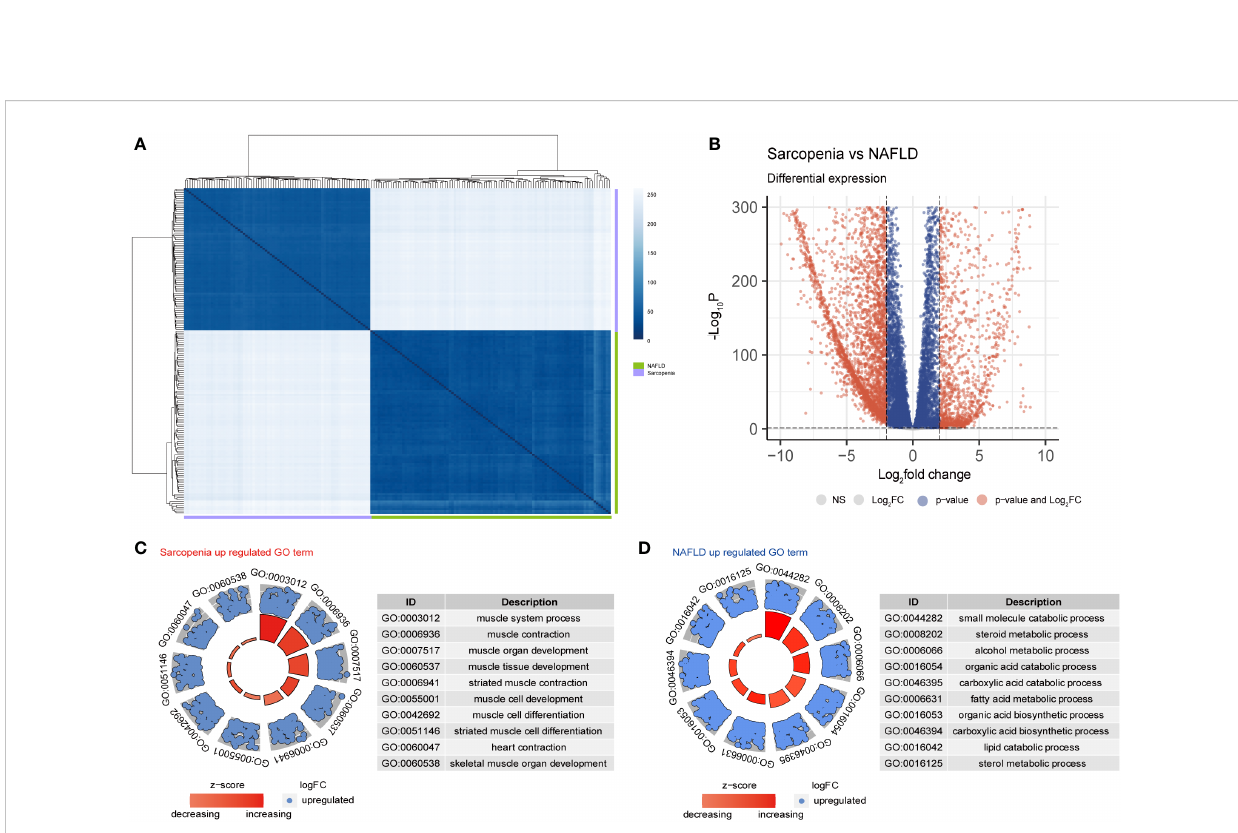
FIGURE 4 Differential gene expression in NAFLD and Sarcopenia. (A) The correlation heatmap of NAFLD and Sarcopenia; (B) Volcanic map showing the differentially expressed genes of NAFLD and Sarcopenia; (C) The GO term of the up-regulated pathways in sarcopenia versus NAFLD; (D) The GO term of the up-regulated pathways in NAFLD versus sarcopenia.